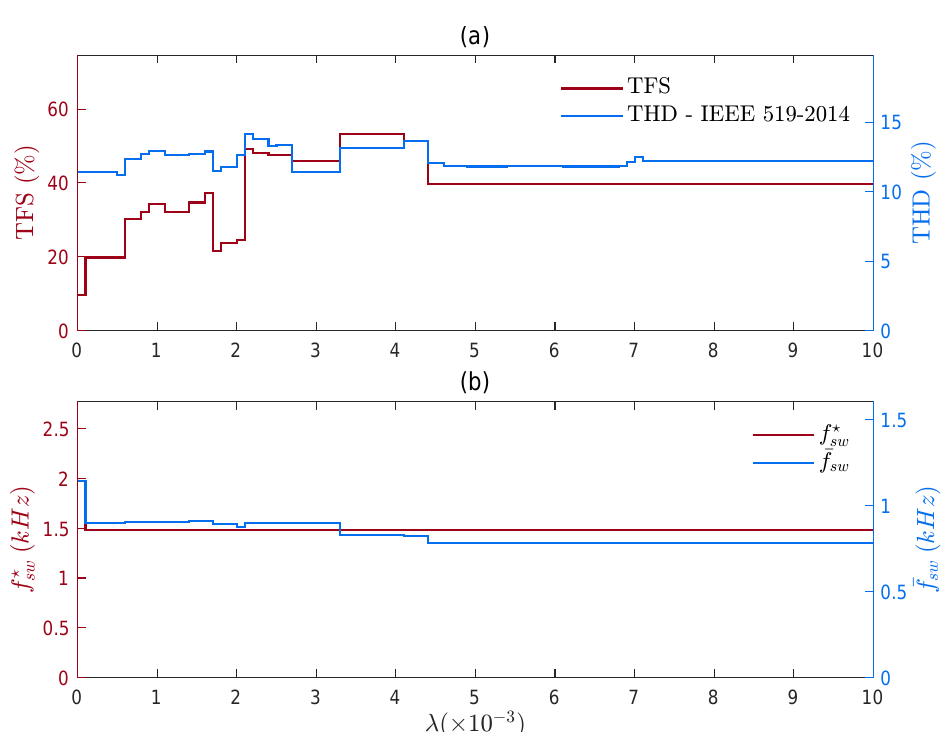
Figure 8. Effect of λ using FCS-MPC with the cost function (12) and sampling period equal to 5940 Hz ( F s = 99 × 60 Hz): ( a ) TFS and THD; ( b ) f (cid:63) sw and ¯ f sw .